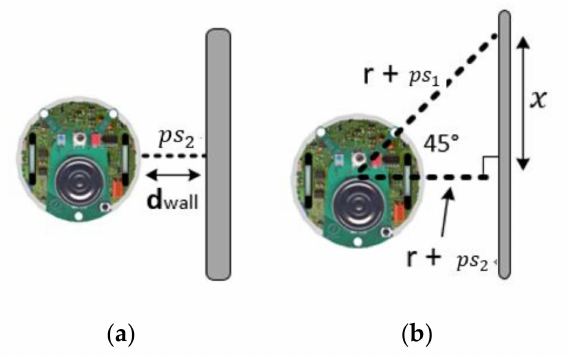
Figure 19. ( a ) Distance the mobile robot kept from the wall and ( b ) degree of parallelism between the mobile robot and the